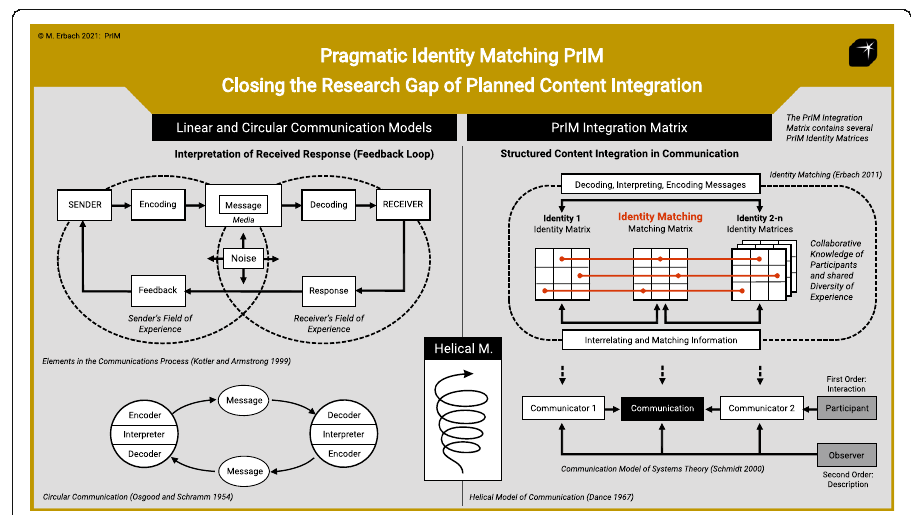
Fig. 11 The PrIM Integration Matrix comprises linear, circular, and spiral